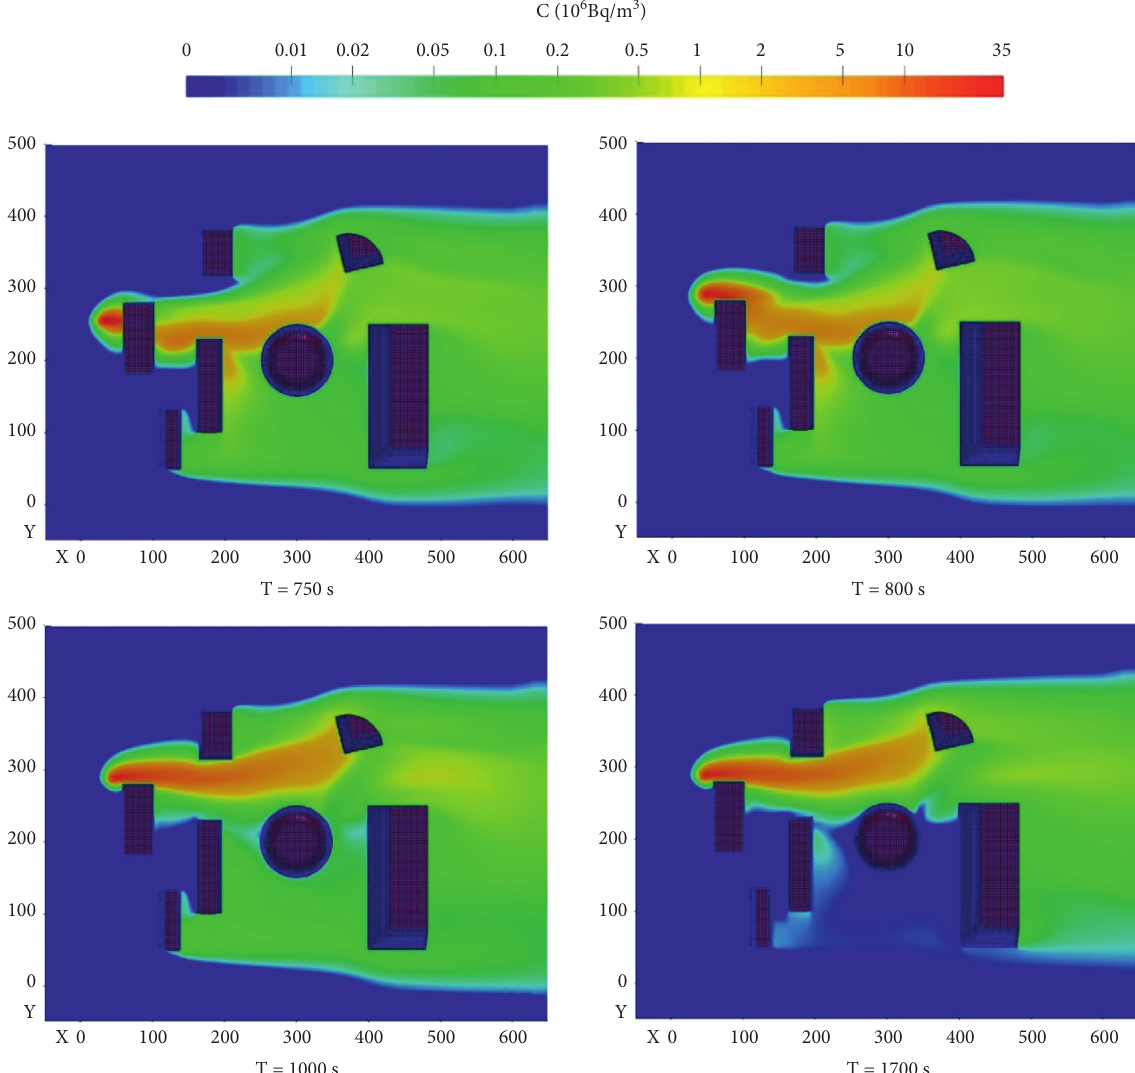
Figure 5: Concentration variation of 137Cs with the motion of source (in the XY plane, where z �